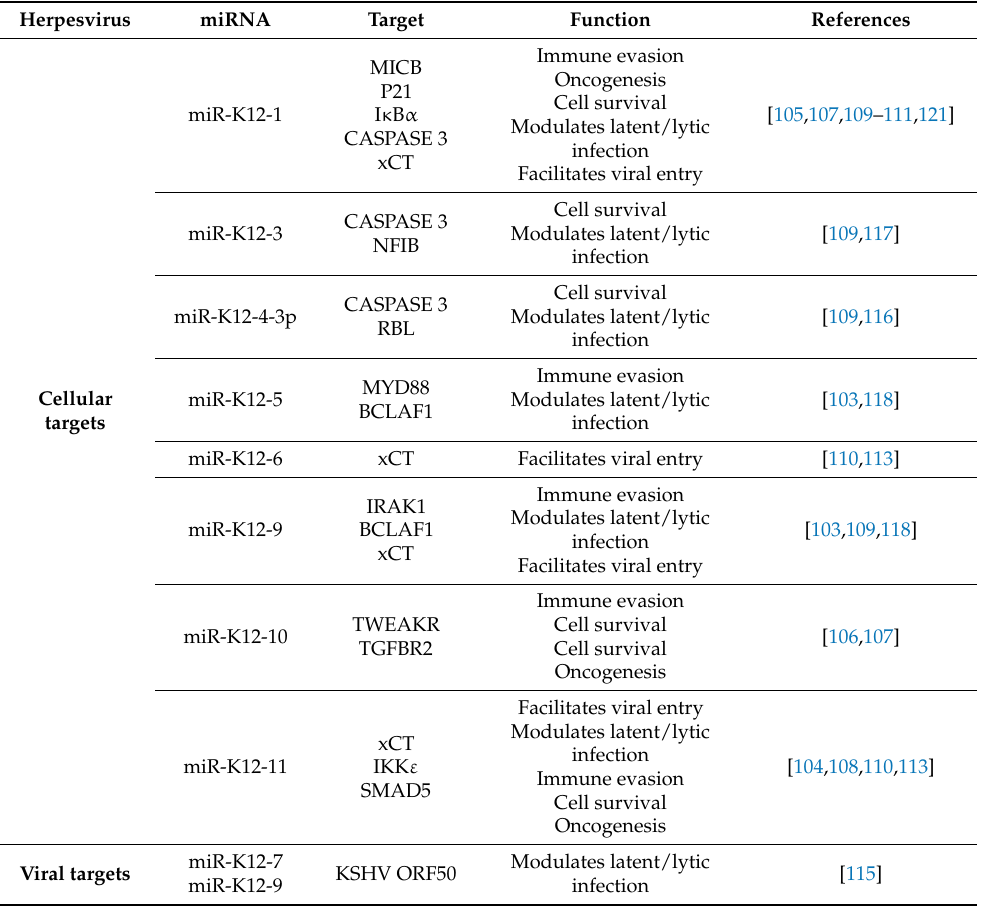
Table 5. Potential cellular and viral targets of KSHV miRNAs 5